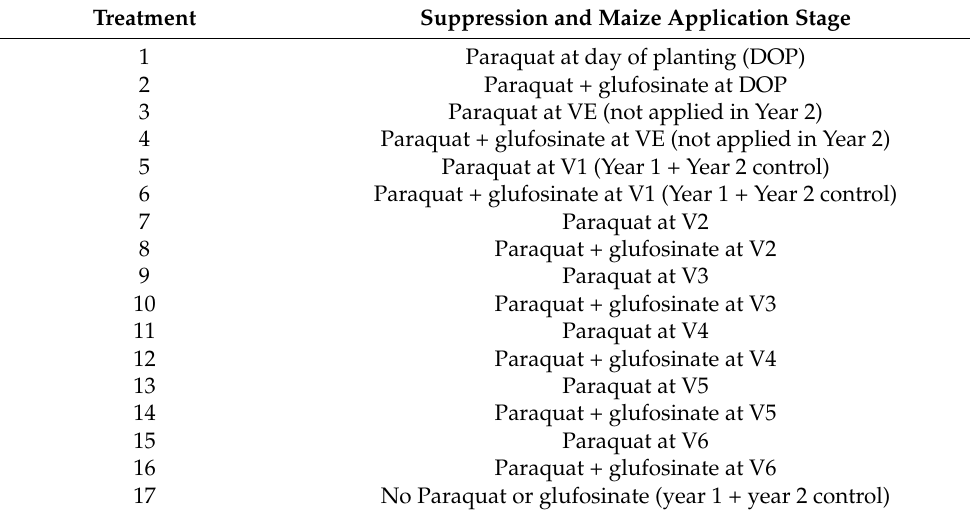
Table 1. Treatments applied at Sorenson Research Farm in 2020 and 2021. Treatment Suppression and Maize Application Stage Paraquat at day of planting